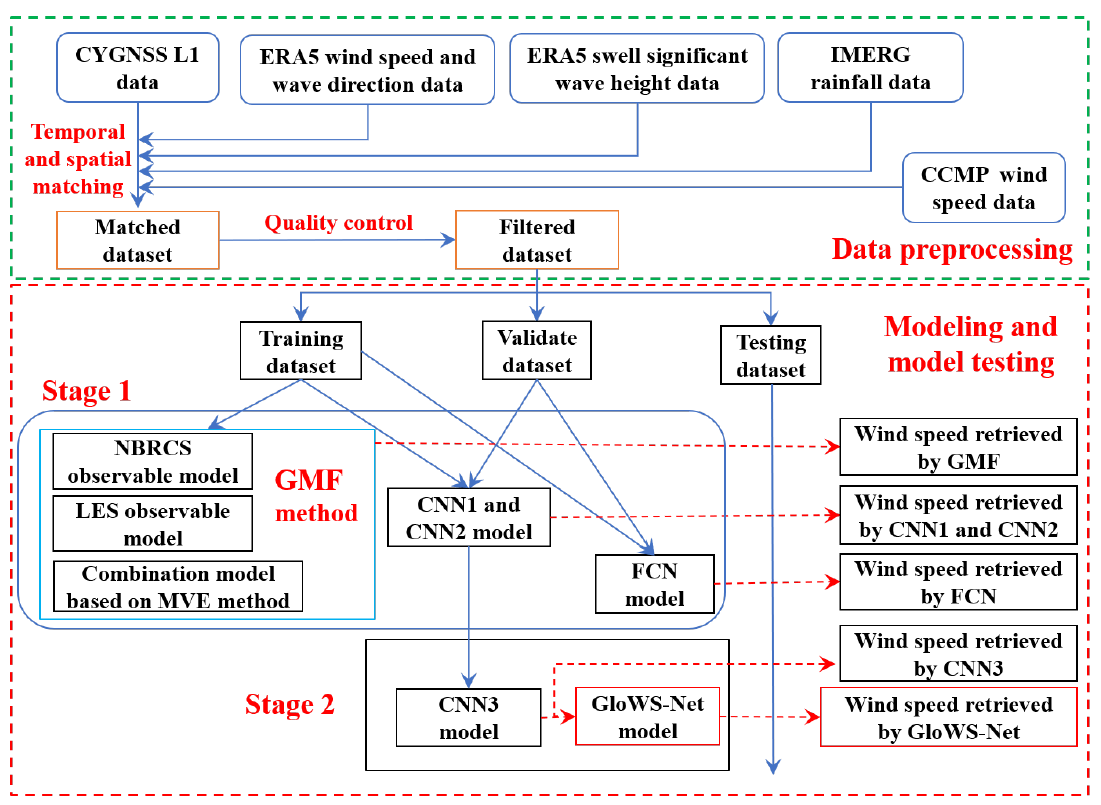
Figure 1. Data processing and model development process of spaceborne GNSS-R sea surface wind speed retrieval.